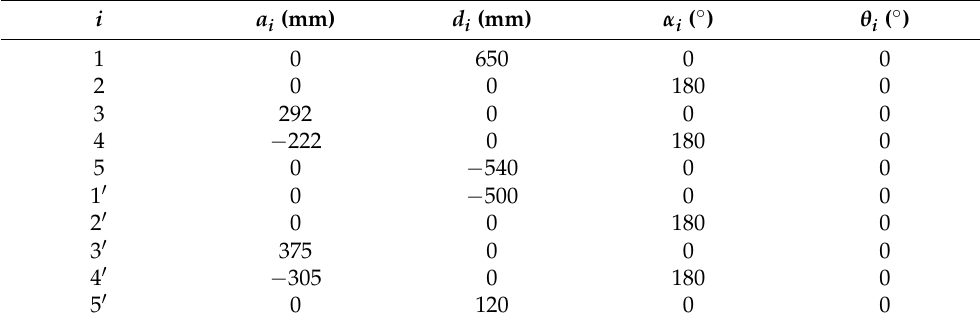
Table 1. The D–H parameters.